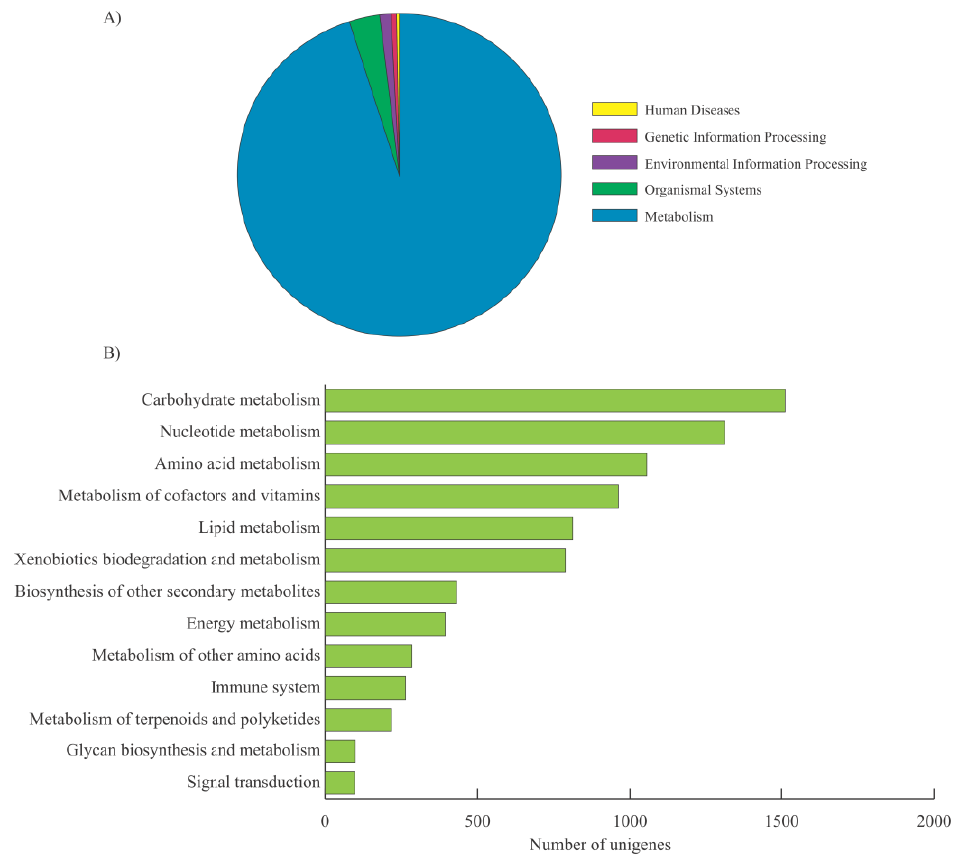
Figure 3. Enrichment analysis of the KEGG pathways assigned to the kenaf unigenes. ( A ) Distribution of the kenaf unigenes in KEGG biological categories. ( B ) Classification of the kenaf unigenes under “metabolism”.